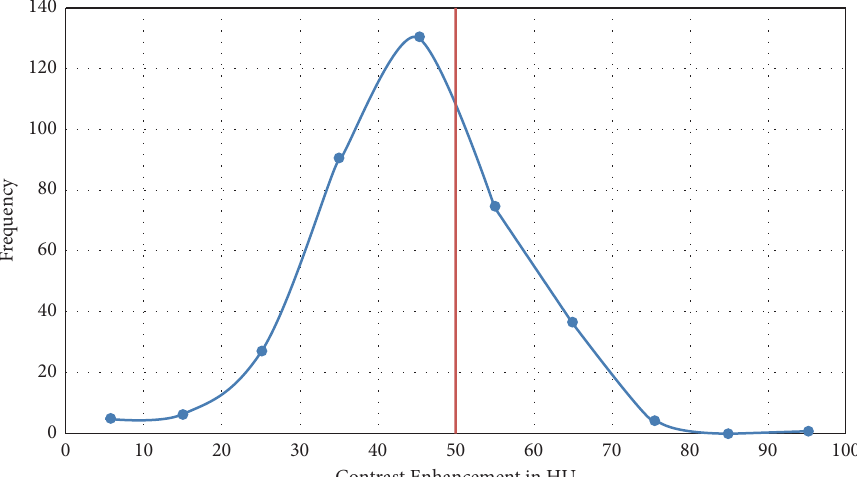
Figure 5: Contrast enhancement level distribution curve in CEIs, with the reference line at 50HU, indicating the minimum required enhancement to label adequate, in patients with precontrast and postcontrast abdominopelvic CTperformed via manual injection protocol at TASH, 2022